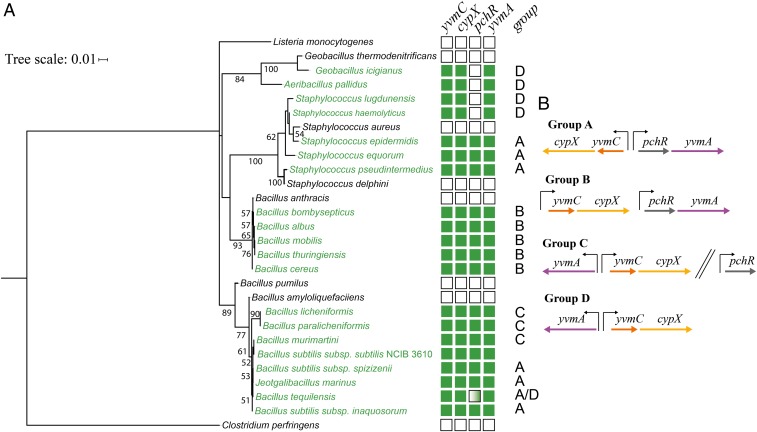
Comparative genomic analysis of the pulcherriminic acid biosynthetic cluster. (A) Phylogenetic tree showing species that contain genes within the pulcherriminic acid biosynthetic cluster. The numbers adjacent to branches indicate the bootstrap values for 350 replicates. Species with members that contain the cluster are shown in green and those without the genes in black. The boxes on the right-hand side show the genes that were identified in the genomes; green is positive and white is negative. The dual green/white box indicates variability in the presence of the gene throughout the genomes. The box containing the letters A–D indicates the genomic organization of the genes in the cluster. (B) The organization of the pulcherriminic acid biosynthetic genes as identified through comparative genome analysis. The black upright arrows represent promoters and the two parallel slanted lines indicate a gap in the genome between the gene.